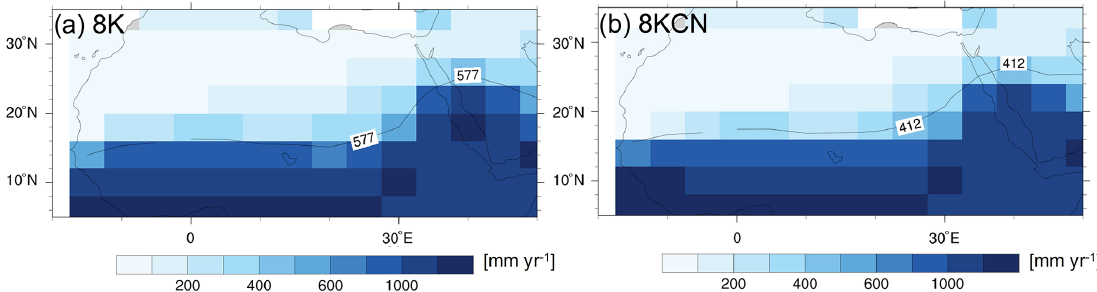
Figure 6. Annual precipitation in North Africa from (a) the 8K and (b) 8KCN simulations. The minimum amount of precipitation for the vegetation growth boundary is plotted as a black line with its values.